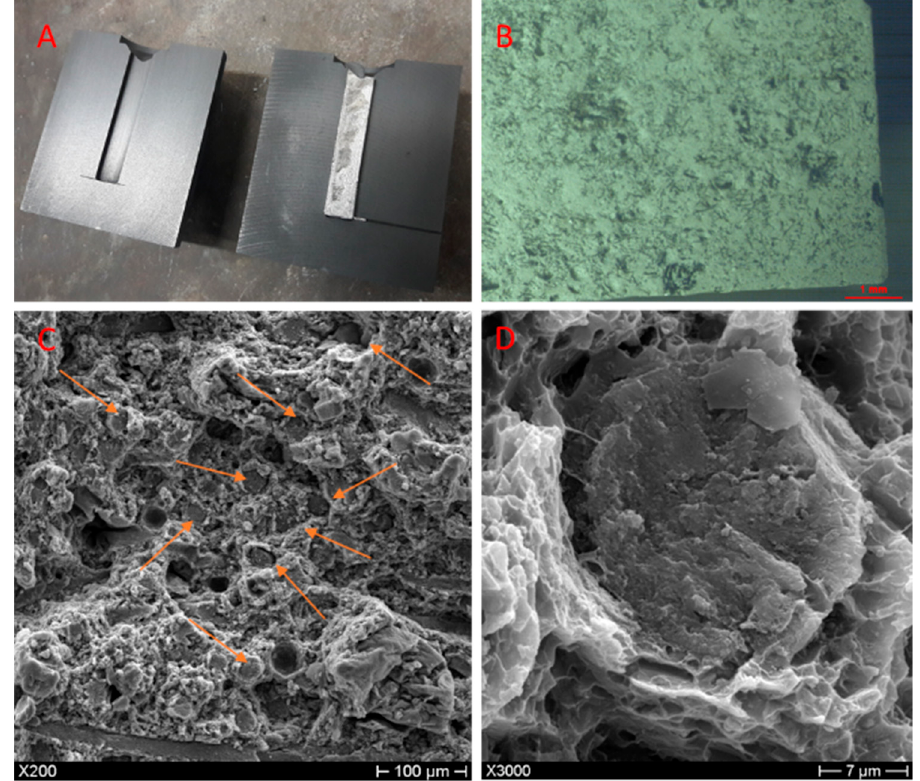
Figure 3. ( A ) Sample after casting with short fillers. ( B ) Cutting surface after acid treatment. ( C ) Fracture surface of sample with short fillers. ( D ) Enlargement of one single short basalt fiber.